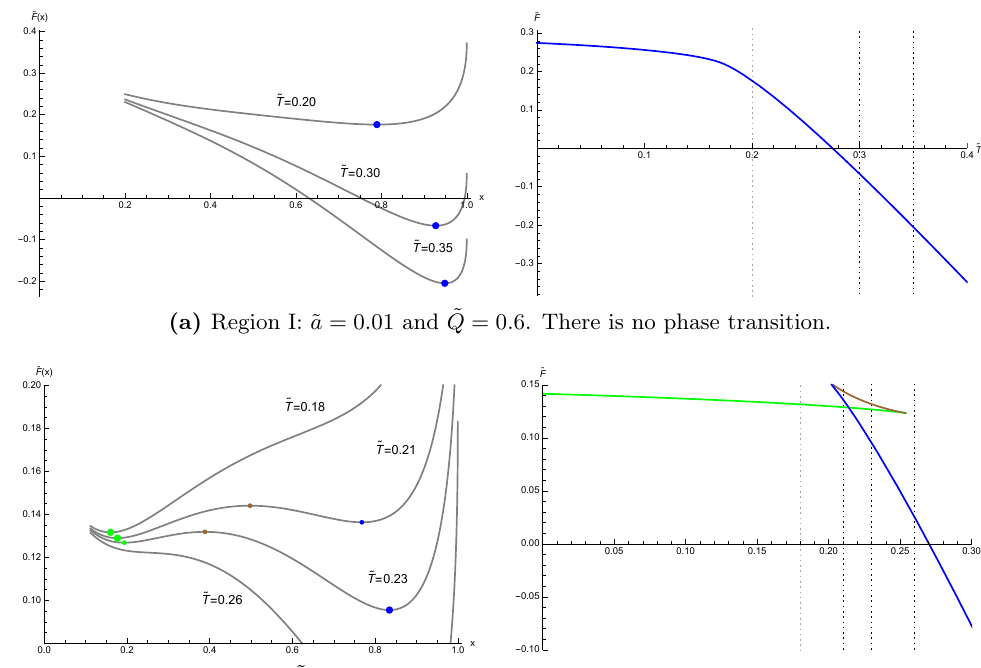
Figure 3. Plots of the free energies ~ F ( x ) and ~ F against ~ T for the BI BHs in Regions I and II. The BI BHs in these regions are RN type. The BI BHs on the blue and green branches (dots) are thermally stable. Left Panels : ~ F ( x ) is plotted for various values of ~ T , which are depicted by the vertical black dotted lines in the right panels. The locally stationary points of ~ F ( x ) are marked with colored dots, the colors of which correspond to these of segments in (cid:12)gure 2. Larger dots represent global minima of ~ F ( x ), which are globally stable. Right Panels : the values of ~ F ( x ) evaluated at the locally stationary points are plotted against ~ T . Their colors match these in the left panels and (cid:12)gure 2, which means that blue/green branches are Large/Small BH, and the brown branch is Intermediate